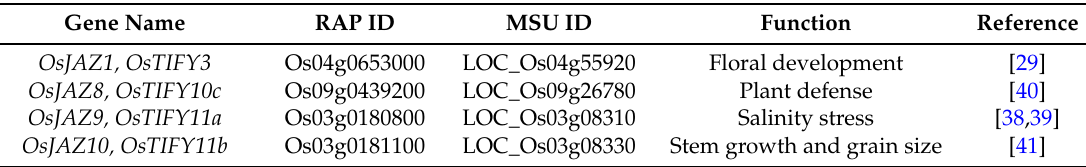
Table 1. Functional assignment to specific OsJAZ genes. Identification (ID) number according to MSU and RAP are